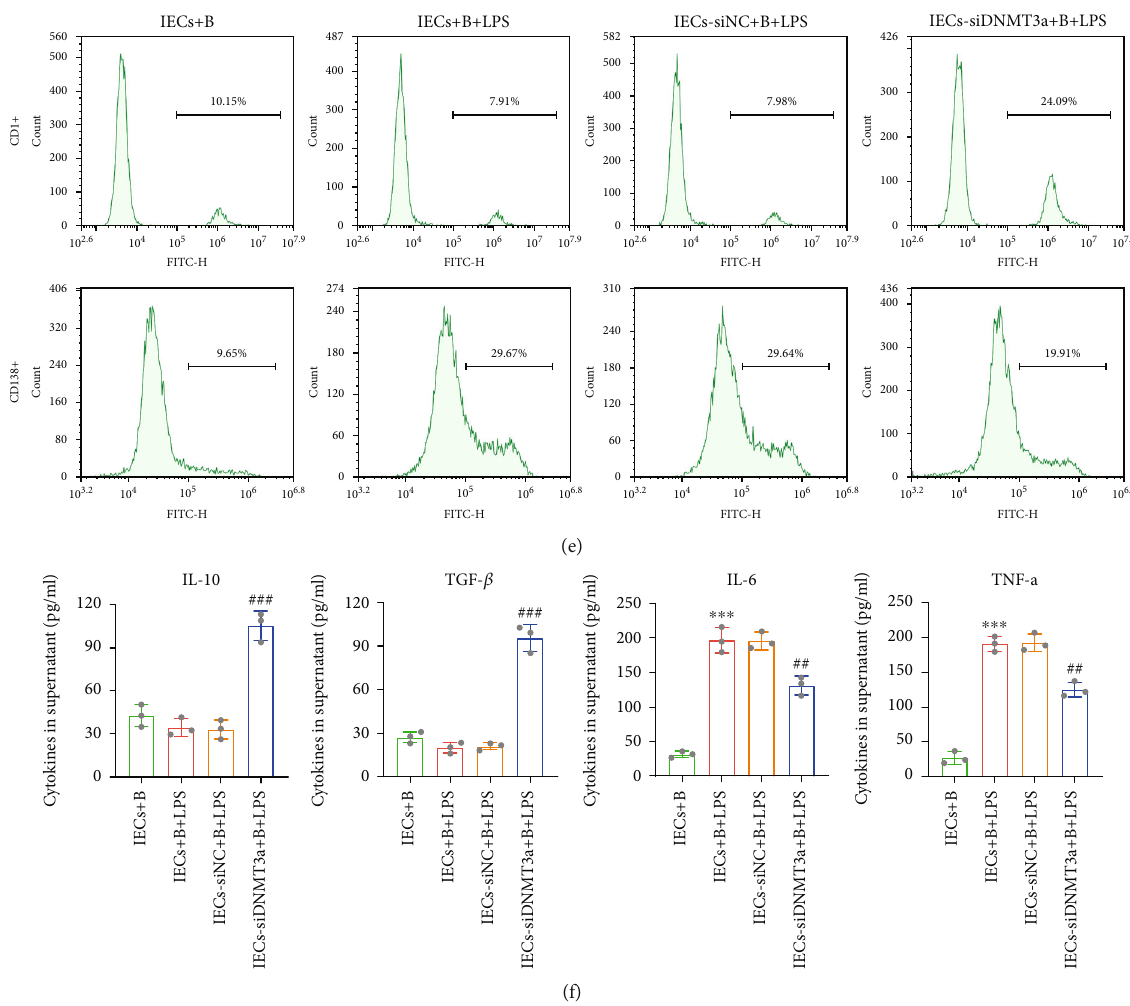
Figure 3: DNMT3a regulates intestinal epithelial barrier function and di ff erentiation of B cells. The primary IECs were isolated from intestinal epithelial tissues of mice. B cells were isolated from the spleens of wide-type mice. Then, the si-DNMT3a or si-NC was transfected into IECs and then treated with LPS (1 μ g/mL) for 48 h. Cells were divided into 4 groups: IECs, IECs+LPS, IECs-si-NC+LPS, and IEC-si-DNMT3a+LPS. (a) DNMT3a mRNA level and protein level in each group of IECs were measured. (b) After transfection of si-DNMT3a or si-NC for 24h, IECs were cocultured with B cells in a cocultural system, and LPS (1 μ g/mL) was added into IECs and cultured for 48 h. Four groups were assigned as follows: IECs+B, IECs+B+LPS, IEC-si-NC+B+LPS, and IEC-si-DNMT3a+B+LPS. TEER of IECs in each group was detected. (c) and (d) ZO-1 and occludin protein levels were measured by western blot and immuno fl uorescence staining. (e) The CD1d+ B cells and CD138+ B cells were detected by fl ow cytometry. (f) IL-10, TGF- β , IL-6,